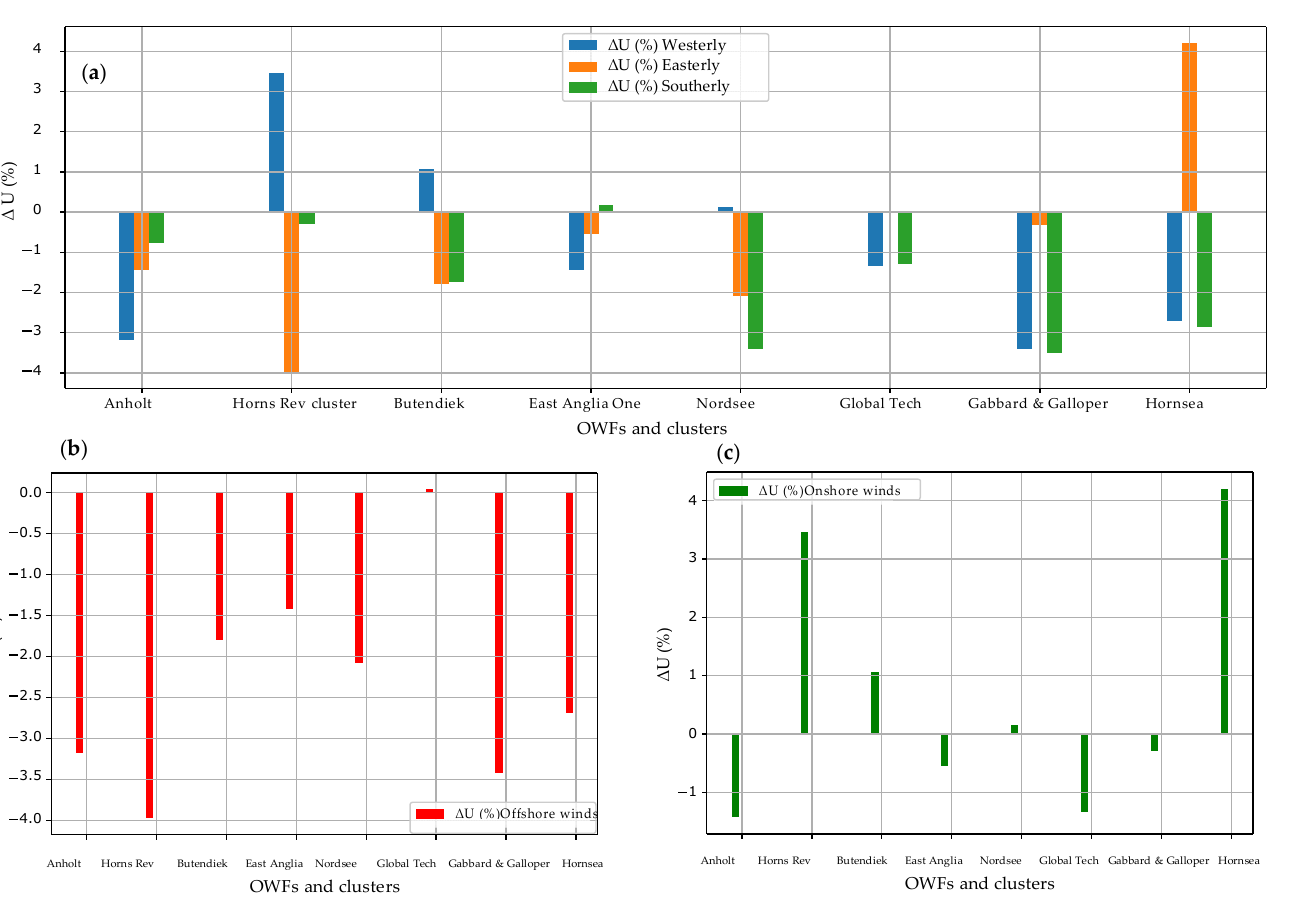
Figure 10. Velocity deficit ( ∆ U ) variation for ( a ) all wind sectors at the investigated sites, ( b ) offshore, and ( c ) onshore winds. Only westerly and easterly wind sectors are considered to be offshore and onshore winds.